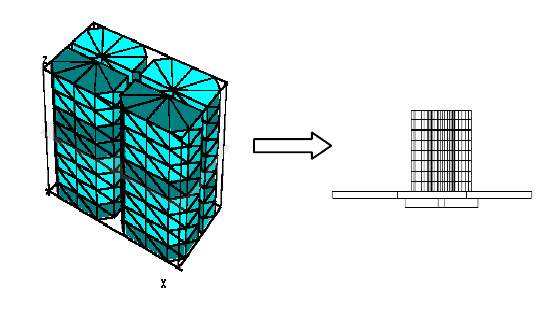
Figure 4. Cube generated from tetrahedrons for volume parcels